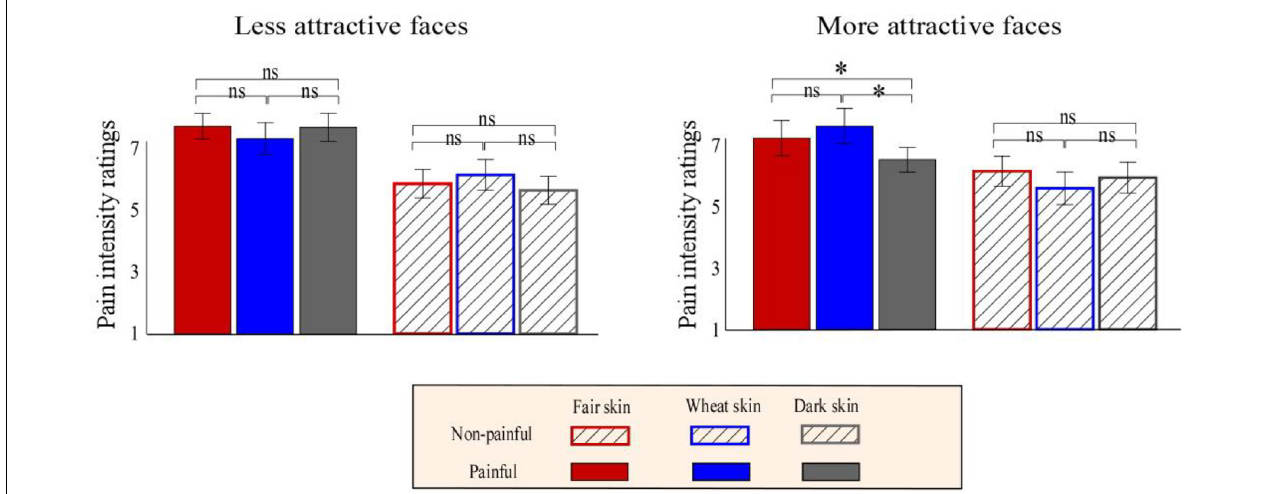
FIGURE 3 | Bar charts of pain intensity ratings. Bar charts of the more attractive (right panel) or less attractive (left panel) faces with fair (red), wheat (blue), and dark (gray) skin with non-painful (linear) or painful (solid) cues. Data are expressed using means ± standard error of the mean. ns: p > 0.05, ∗ p < 0.05, ∗∗ p < 0.01, ∗∗∗ p <